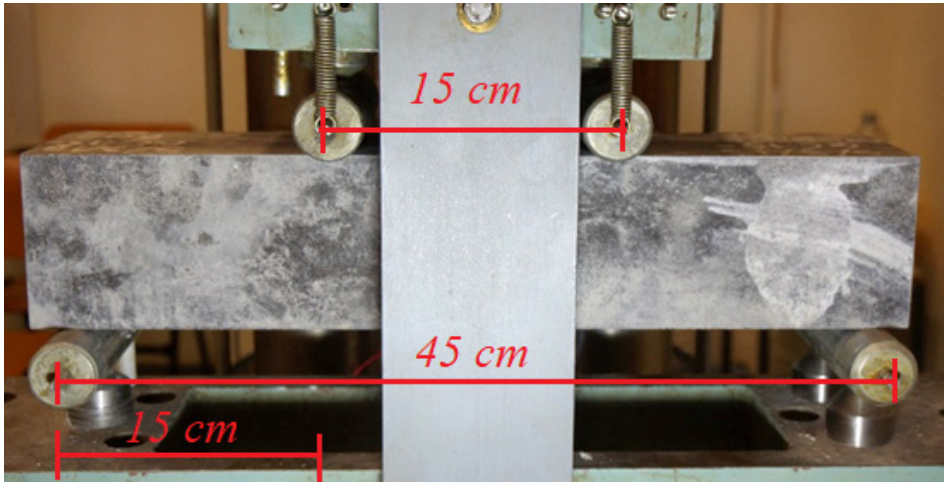
Figure 4. GC beam during the two-point bending test.